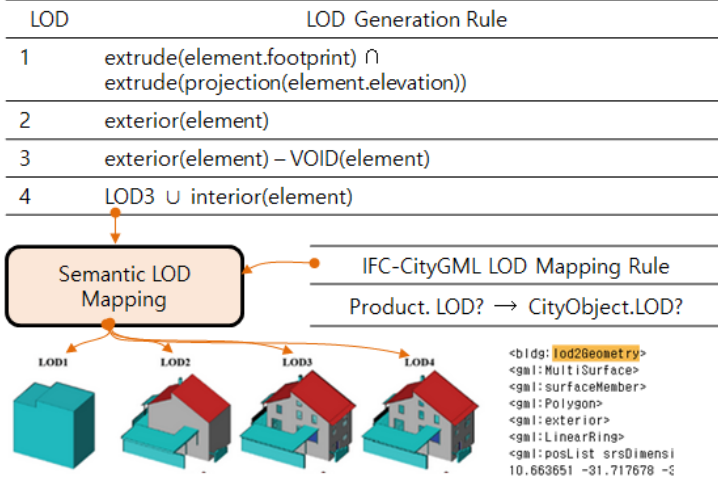
Figure 16. B2G LM rule set concept.